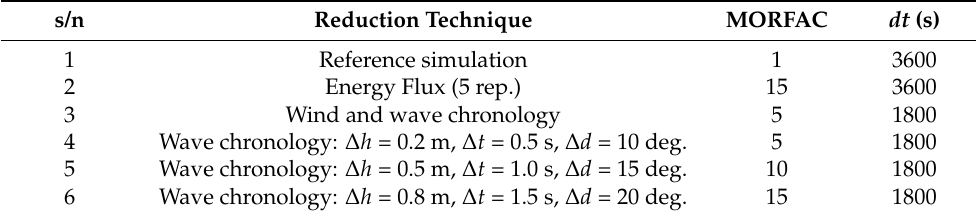
Table 1. Input parameters of the different simulations.